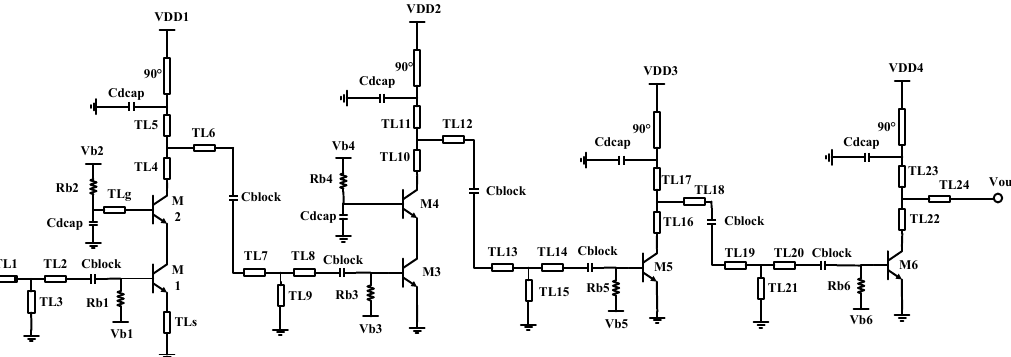
Figure 2. The schematic of the proposed wideband LNA.